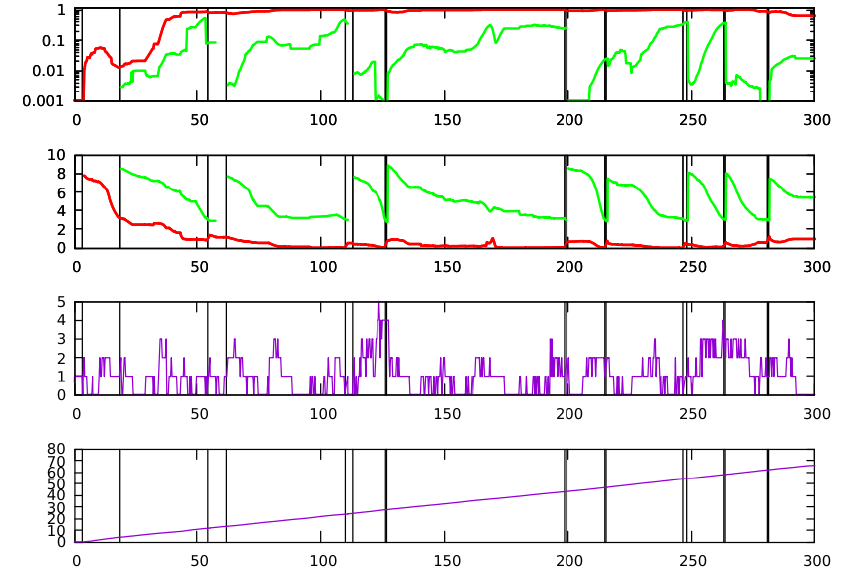
Figure 4. Time evolution (in seconds) of the concurrent filter. At first plot the normalized accuracy (red shows the LT filter and green shows the ST filter) is shown. Second plot represents the entropy (red shows the LT filter and green shows the ST filter). The third figure shows the number of detected doors. Fourth figure represents the travelled distance. Vertical lines represent the different times when the firing and resetting conditions are